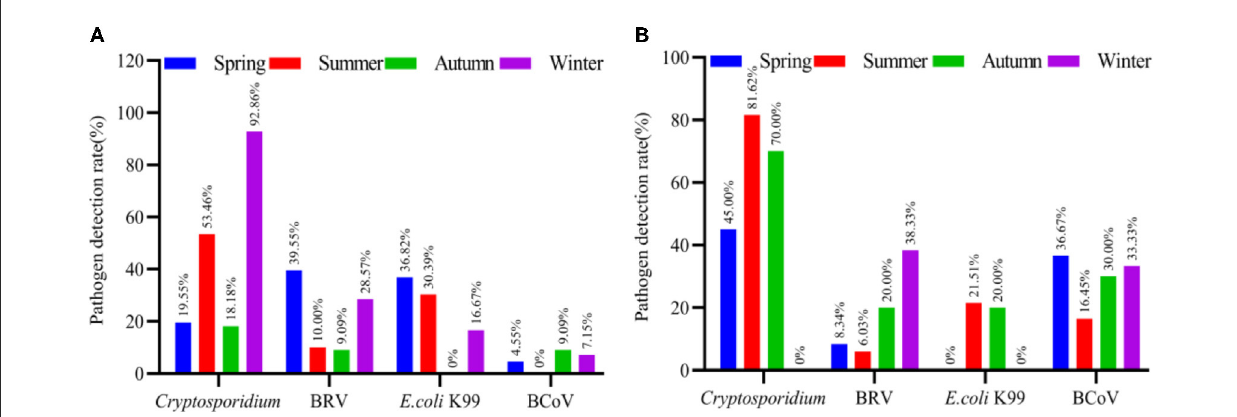
FIGURE5 The detection rate of normal and diarrhea samples in different seasons [ (A) Yinchuan, (B) Wuzhong]. The number of cattle farms in Yinchuan and Wuzhong, where samples were collected at different seasons, and the detection rates of Cryptosporidium , BRV, E. coli K99, and BCoV in each cattle farm were counted.